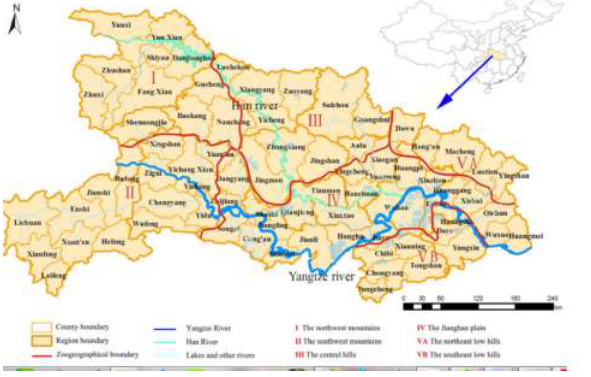
Figure 1 . Hubei province and its position in